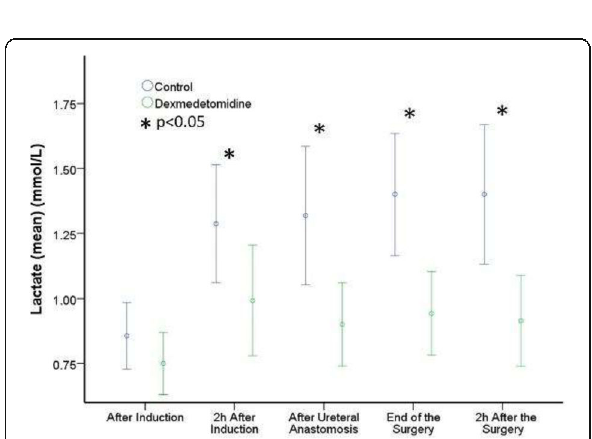
Fig. 2 (abstract 0064). Lactate level in the two groups at different time points